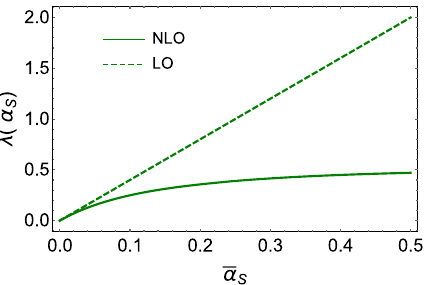
(cid:20) (cid:19) − ω < 1 which we will dis- γ